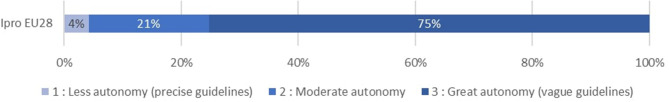
Autonomy in work methods.